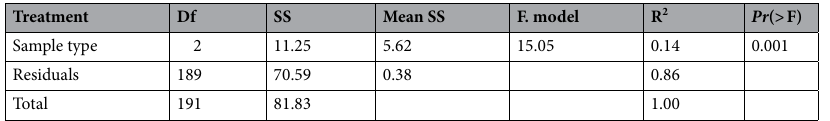
Table 2. PERMANOVA results based on Bray–Curtis dissimilarities evaluating differences in the bacterial community composition between Aedes japonicus , Aedes triseriatus , water samples. P-values are based on 999 permutations.